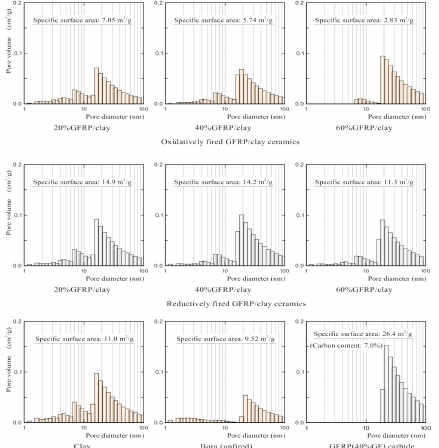
Figure 3. Pore size distributions in the samples.